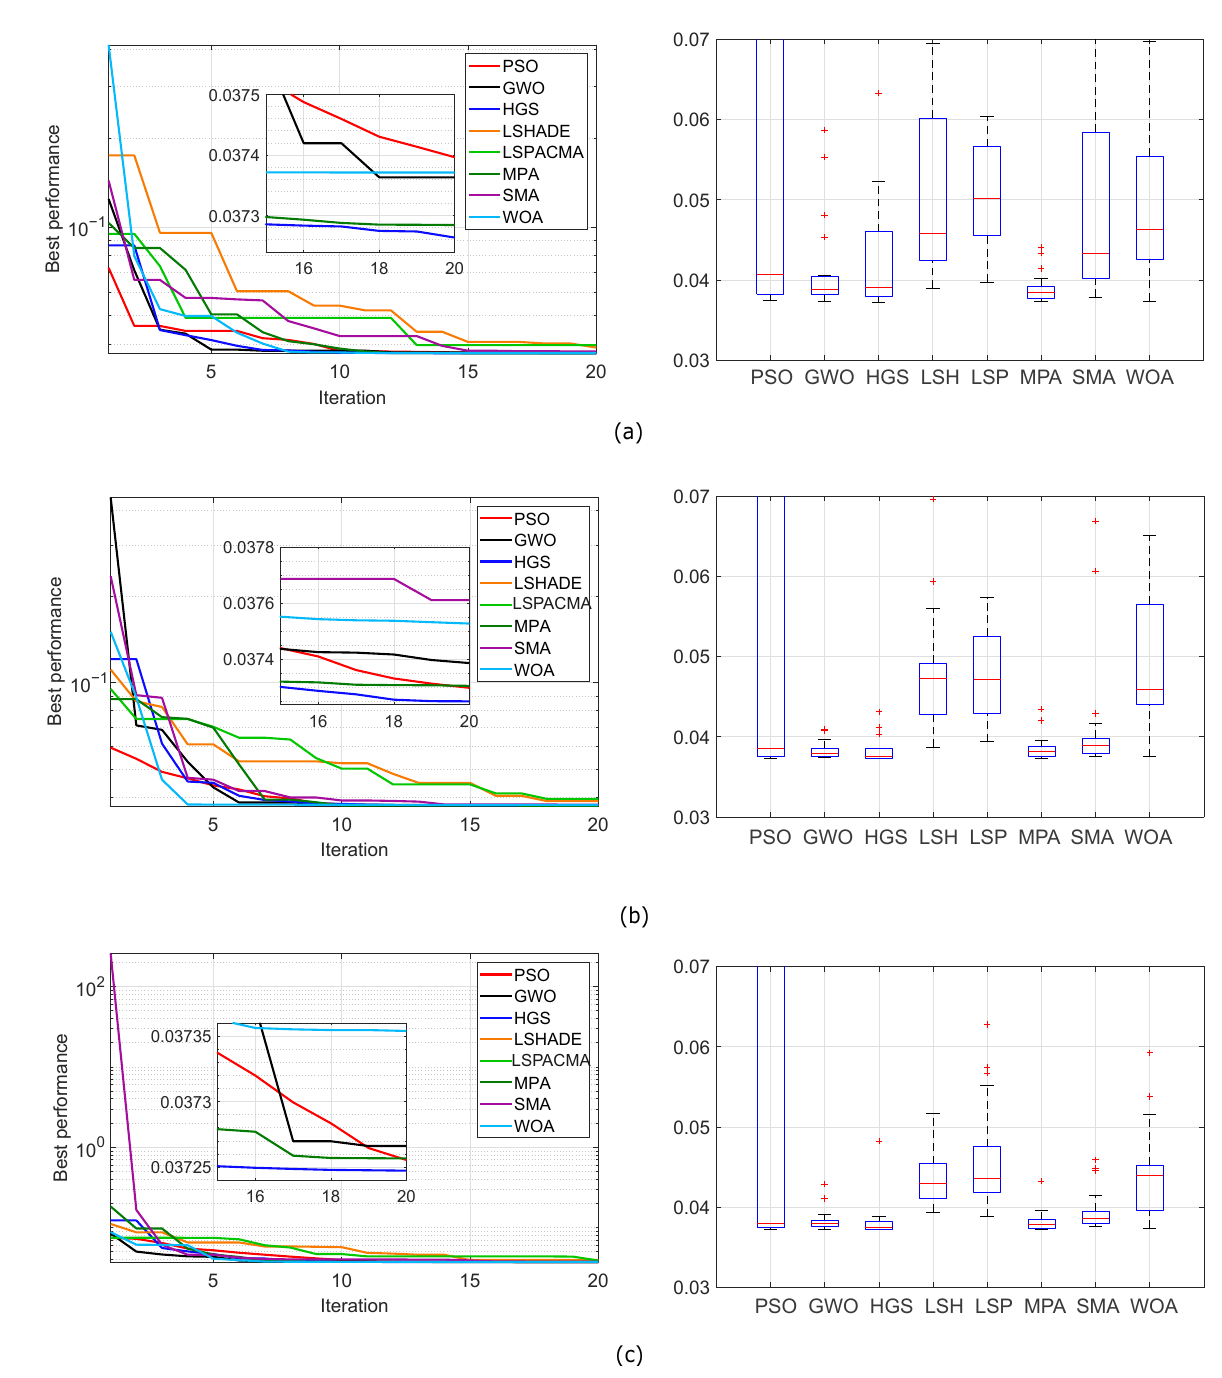
Figure 5. Convergence curves of RMSE and boxplot distribution of the different algorithms, iterations and individuals. ( a ) 20 individuals, 20 iterations; ( b ) 30 individuals, 20 iterations; ( c ) 40 individuals, 20